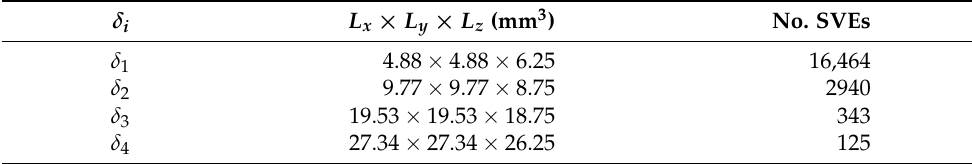
Table 1. Size of window and total number of SVEs corresponding to each δ i